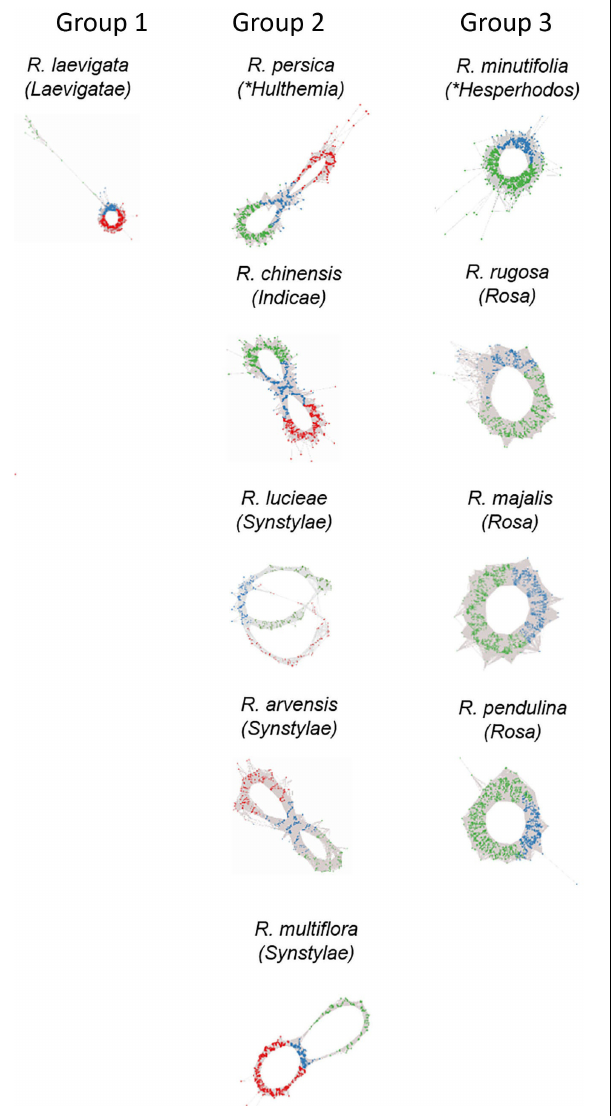
chromosome in R. canina where both probes were